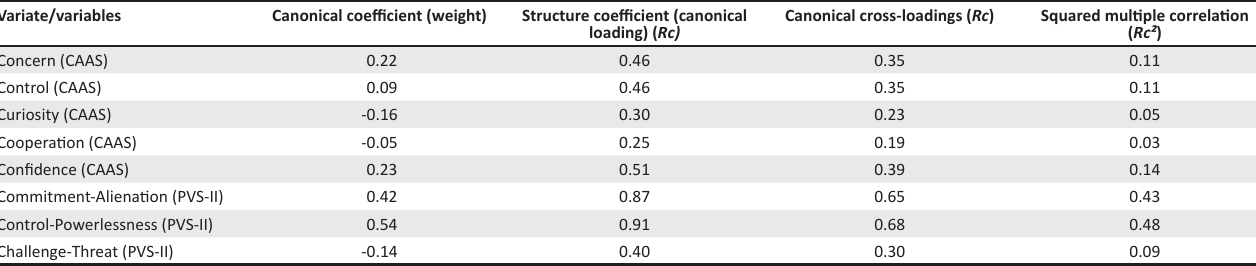
TABLE 4a: Standardised canonical correlation analysis results for the first canonical function variate . Variate/variables Canonical coefficient (weight) Structure coefficient (canonical Canonical cross-loadings ( Rc ) Squared multiple correlation loading) ( Rc) ( Rc² ) Perception of emotion (AES) -0.0001 0.33 0.24 0.06 Managing own emotions (AES) 0.50 0.28 Utilising emotions (AES) Managing others’ emotions (AES) Comprehension (OLQ) Manageability (OLQ) 0.09 0.58 0.44 0.19 Meaningfulness (OLQ) 0.19 0.68 0.51 0.26 Exhaustion (MBI) -0.14 -0.62 0.22 Professional efficacy (MBI) Cynicism (MBI) -0.43 0.30 N = 409; AES, Assessing Emotions Scale; OLQ, Orientation to Life Questionnaire; MBI, Maslach Burnout Inventory; CAAS, Career Adapt-Abilities Scale; PVS-II, Personal Views Survey II; df , degree of freedom; * p ≤ 0.05; ** , p ≤ 0.01; *** , p ≤ 0.001. Overall model fit measures (function 1): Overall Rc² = 0.56